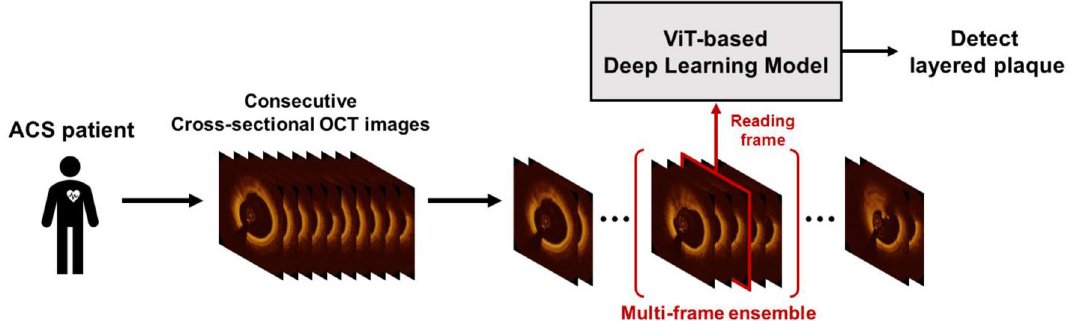
Figure 2. Vision transformer (ViT)-based deep learning model for diagnosis of layered plaque. The proposed ViT-based deep learning model detects the faint sign of layered plaque more accurately than the standard convolutional neural network (CNN)-based deep learning model by maximally utilizing attention mechanism, and further improves its performance via multi-frame ensemble method, which resembles the recognition process of the experienced OCT reader. OCT, optical coherence